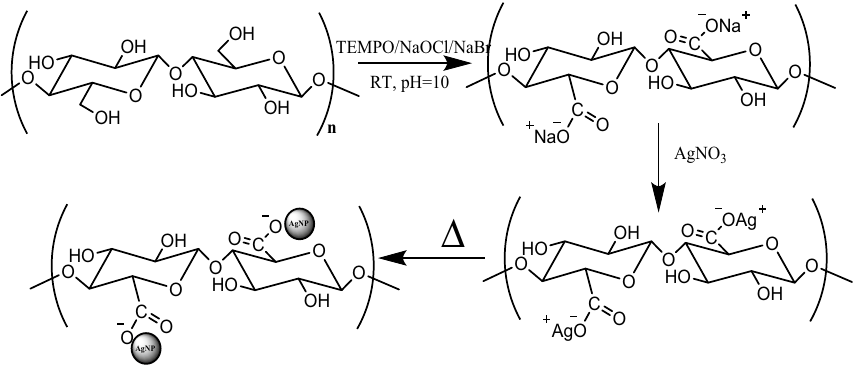
Figure 1. Schematic illustration showing the substitution of Ag + ions onto PVA-TOCNFs, and the subsequent formation of